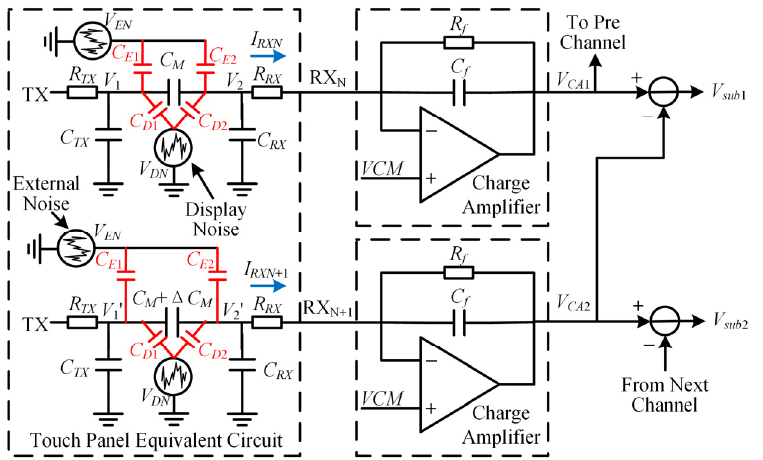
Figure 1. Two adjacent received channel differential operation circuits and touch panel equivalent circuits with noise sources.